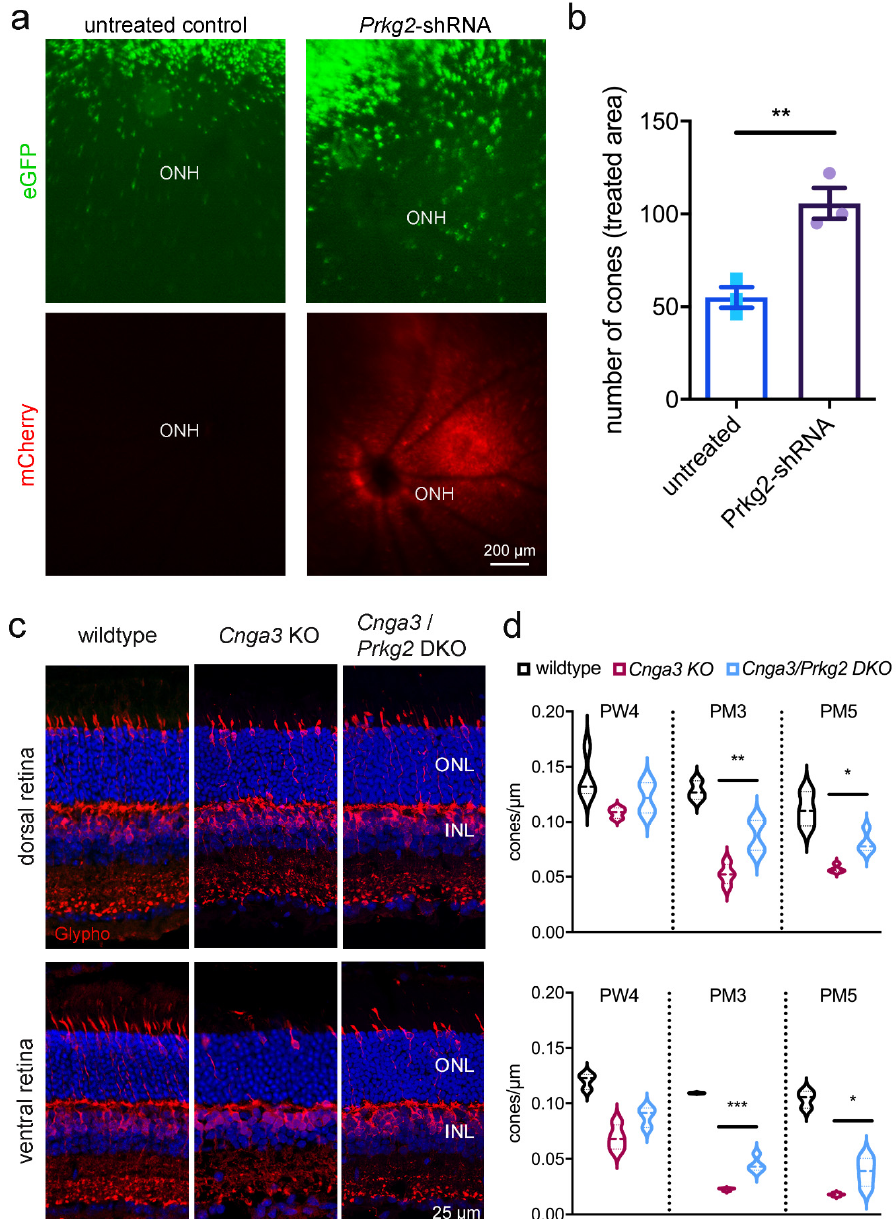
Figure 3. Downregulation or knockout of Prkg2 delays cone degeneration in Cnga3 KO mice. ( a , b ) Subretinal administration of AAV vectors encoding a shRNA directed against Prkg2 preserves the number of cones (green) in RG-eGFP/ Cnga3 KO mice. The retinal area targeted by the subretinal injection of the AAV vector is indicated by the fundus fluorescence signal of the vector-encoded mCherry (red) (lower panel in a ). The scale bar applies to all images. ( b ) Quantification of the number of eGFP-positive cones from fundus fluorescence images revealed a significant preservation upon AAV- Prkg2 -shRNA treatment at 3 months after injection ( n = 3, ** p < 0.01 Student’s t -test). Error bars shown are SEM. ONH, optic nerve head. ( c , d ) Genetic inactivation of Prkg2 preserves Cnga3 -deficient cone photoreceptors. ( c ) Cone morphology in wildtype, Cnga3 KO and Cnga3/Prkg2 double knockout (DKO) retina visualized by immunolabeling of glycogen phosphorylase (glypho). The anti-glypho signal is found in cone inner segment, cell body and synapse. In addition, anti-glypho labels bipolar cell bodies and synapses in the outer nuclear layer (ONL) and inner plexiform layer. Panels in C show Hoechst nuclear dye signal in blue. The scale bar applies to all images. ( d ) Violin plot showing quantification of cone numbers from glypho labelled retinal cross-sections revealing a significantly higher density of cones in Cnga3/Prkg2 DKO compared to Cnga3 KO ( n = 3–4, * p < 0.05, ** p < 0.01, *** p < 0.005, 1-way-ANOVA). INL, inner nuclear layer; PM, postnatal month; PW, postnatal